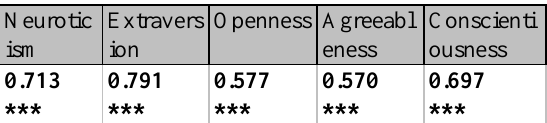
Table 3. Correlation value between the NEO-FFI and IPIP dimensions (N=45) ( ***: P value < 0.001 )